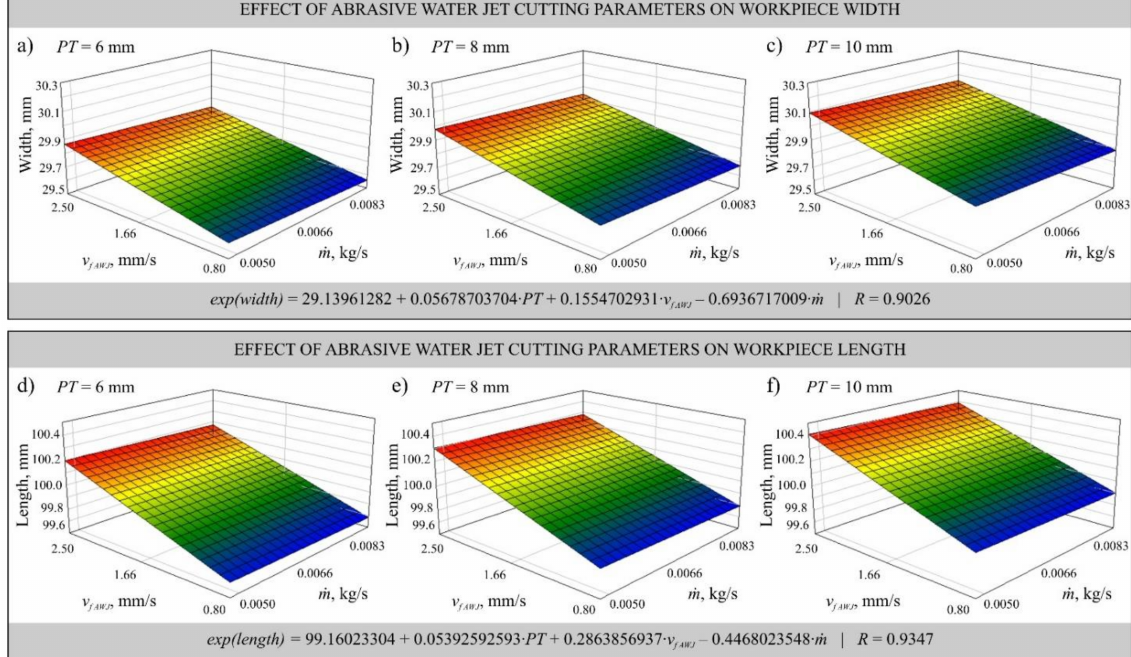
Figure 5. Mathematical models developed using data from measurements of the width ( a – c ) and length ( d – f ) of elements cut by laser beam from plate of thickness PT = 6 mm ( a , d ), PT = 8 mm ( b , e ) and PT = 10 mm ( c , f ) as a function of changes in the AWJ head feed rate v f AWJ and abrasive flow rate ˙m